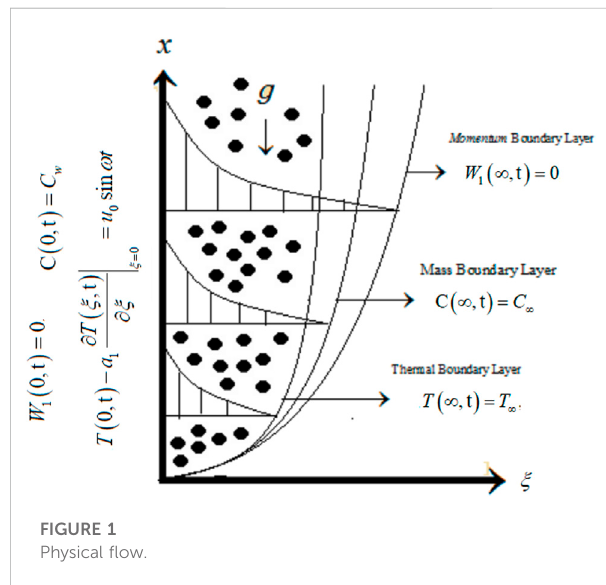
FIGURE 1 Physical fl